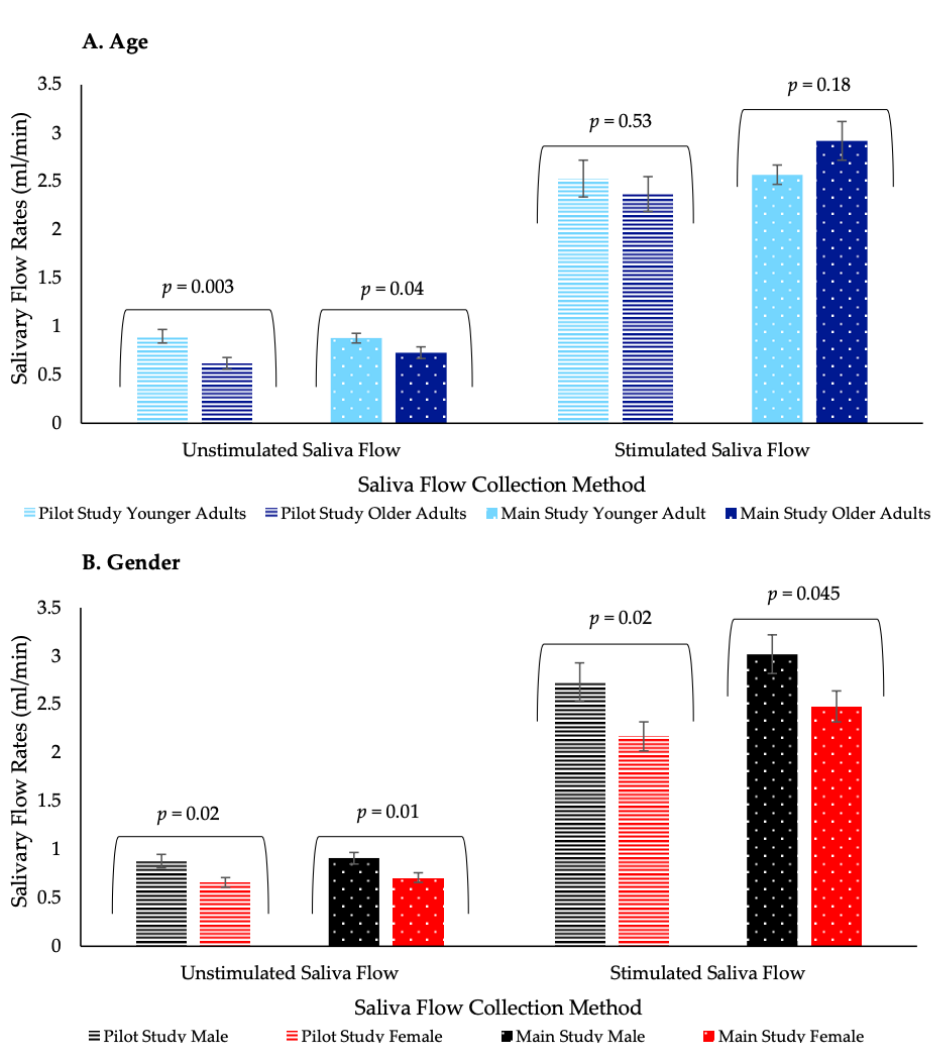
Figure 4. Summary of volunteers’ salivary flow rates (mL/min) in both studies. Values are expressed as least square means (LSM) estimates ± standard error from SAS output. Significant differences (p < 0.05) are reported between groups with relevant p value above each group.